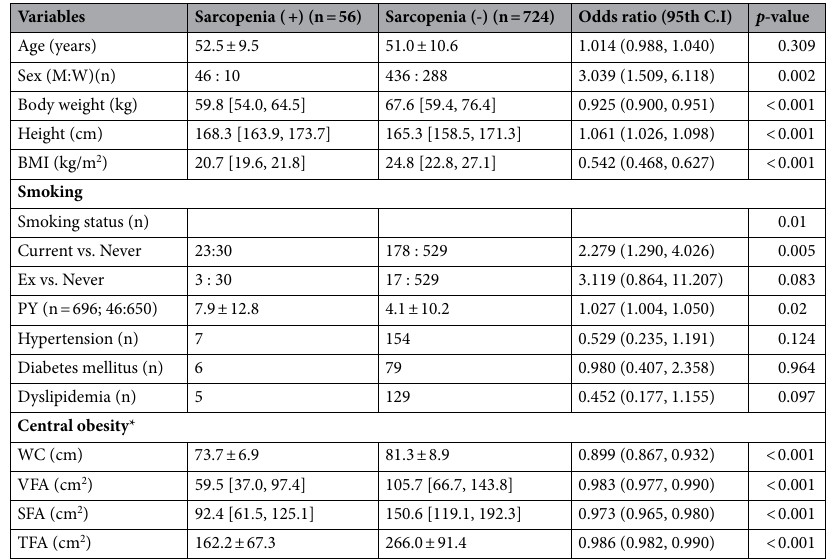
Table 3. Univariate logistic regression analyses for evaluating factors related with sarcopenia defined by skeletal muscle index at 1st lumbar vertebra level (L1-SMI). Numerical variables with normal distribution were provided with mean ± standard deviation, while those not showing normal distribution were provided with median [interquartile range] except pack-year. M = men, W = women, n = number, BMI = body-mass index, PY = Pack-Year, WC = waist circumference, FA = fat area (V:visceral, S:subcutaneous, T:total). *Numbers of evaluated individuals (WC, n = 776, 54:722; VFA, n = 779, 55:724; SFA, n = 739, 55:684; TFA, n = 739,